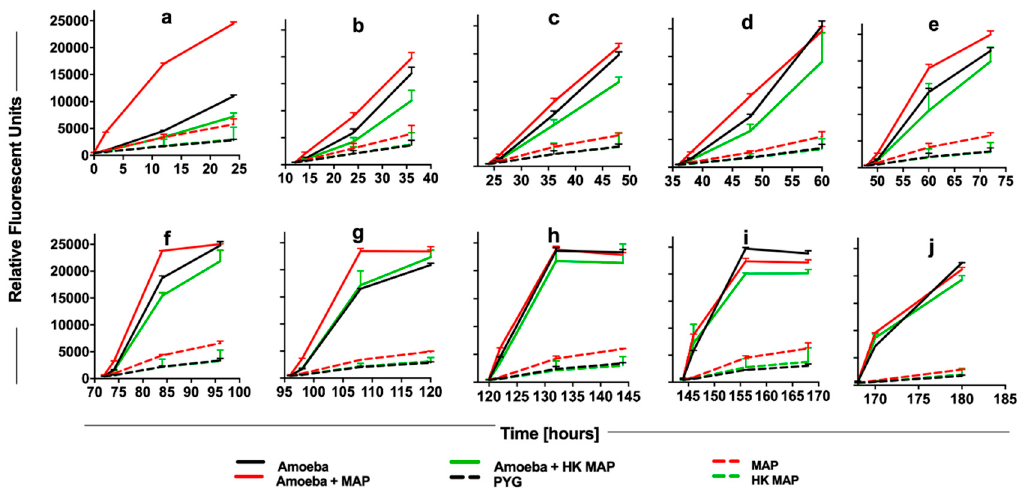
Figure 4. The long-term impact of MAP infection on amoeba metabolism. Amoeba was infected with either live or heat-killed MAP or added only Peptone-Yeast-Glucose (PYG) medium for 2 h. At 0 h ( a ), 12 h ( b ), 24 h ( c ), 36 h ( d ), 48 h ( e ), 72 h ( f ), 96 h ( g ), 120 h ( h ), 144 h ( i ), and 168 h ( j ) alamarBlue was added and fluorescent readings were recorded at 0, 2, 12, and 24 h after the addition of dye. Live and heat-killed bacterial controls in absence of amoeba were included to record the amoeba-independent reduction of dye. PYG media without bacterial and amoeba addition serves as a blank in the assay. The data represent the mean ± SD of three independent experiments each performed in triplicate. HK, heat-killed MAP.